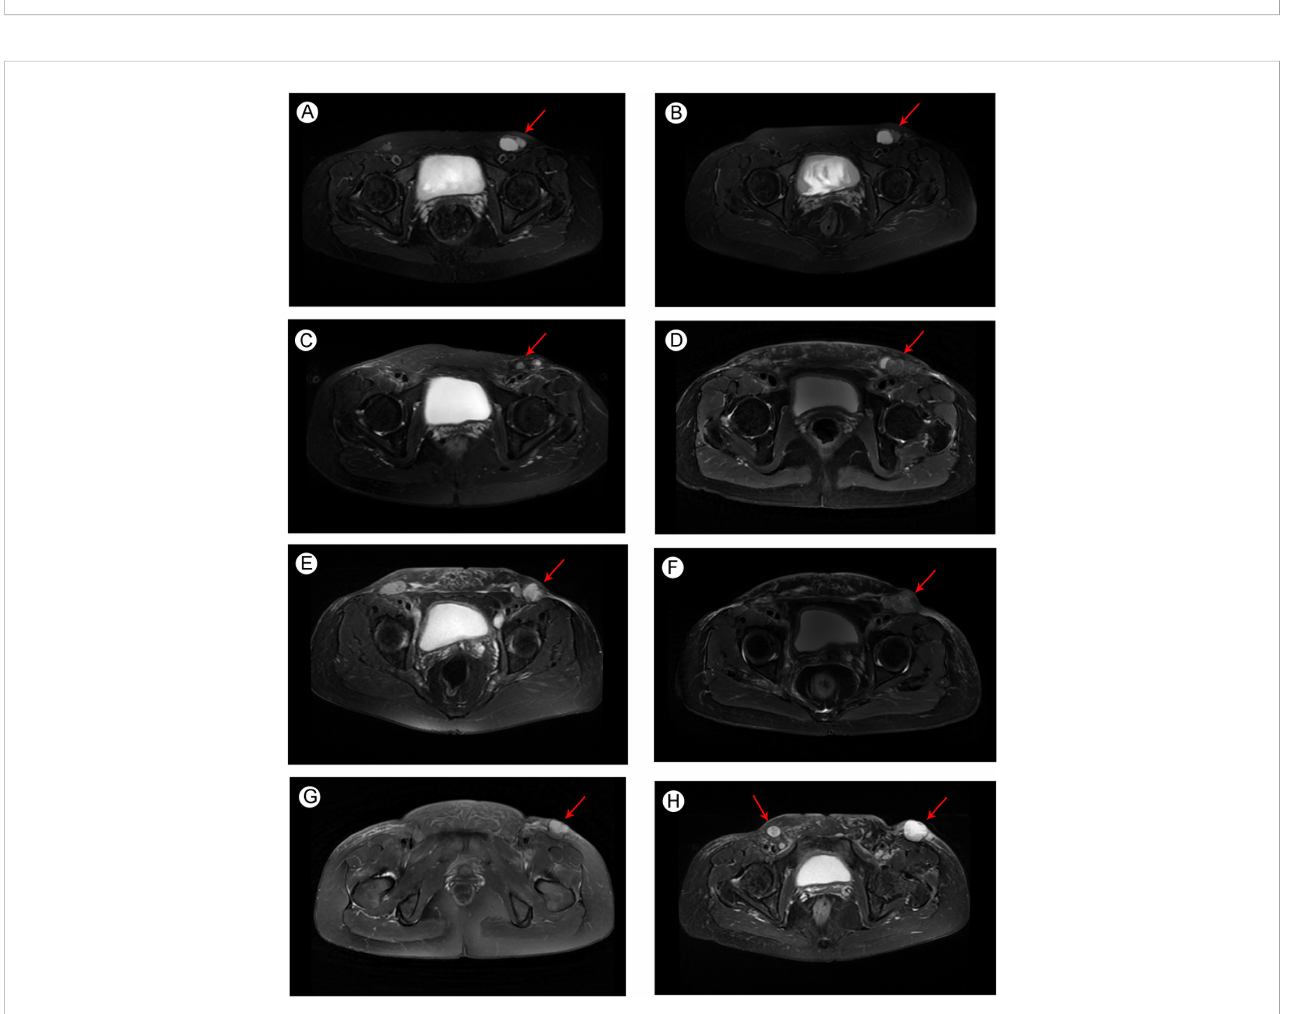
FIGURE 3 Pelvic MRI image of metastatic SGC (A) before docetaxel + nedaplatin treatment in October 2018; (B) after docetaxel + nedaplatin treatment in February 2019; (C) after the radiotherapy in September 2019; (D) before albumin-bound paclitaxel + camrelizumab treatment in December 2019; (E) after albumin-bound paclitaxel + camrelizumab treatment in September 2020; (F) before pemetrexed + nedaplatin + camrelizumab treatment in December 2020; and newly developed metastatic lymph nodes (G) before pemetrexed + nedaplatin + camrelizumab treatment in December 2020; (H) after pemetrexed + nedaplatin + camrelizumab treatment in March 2021. Arrows indicate the tumors in the groin region.